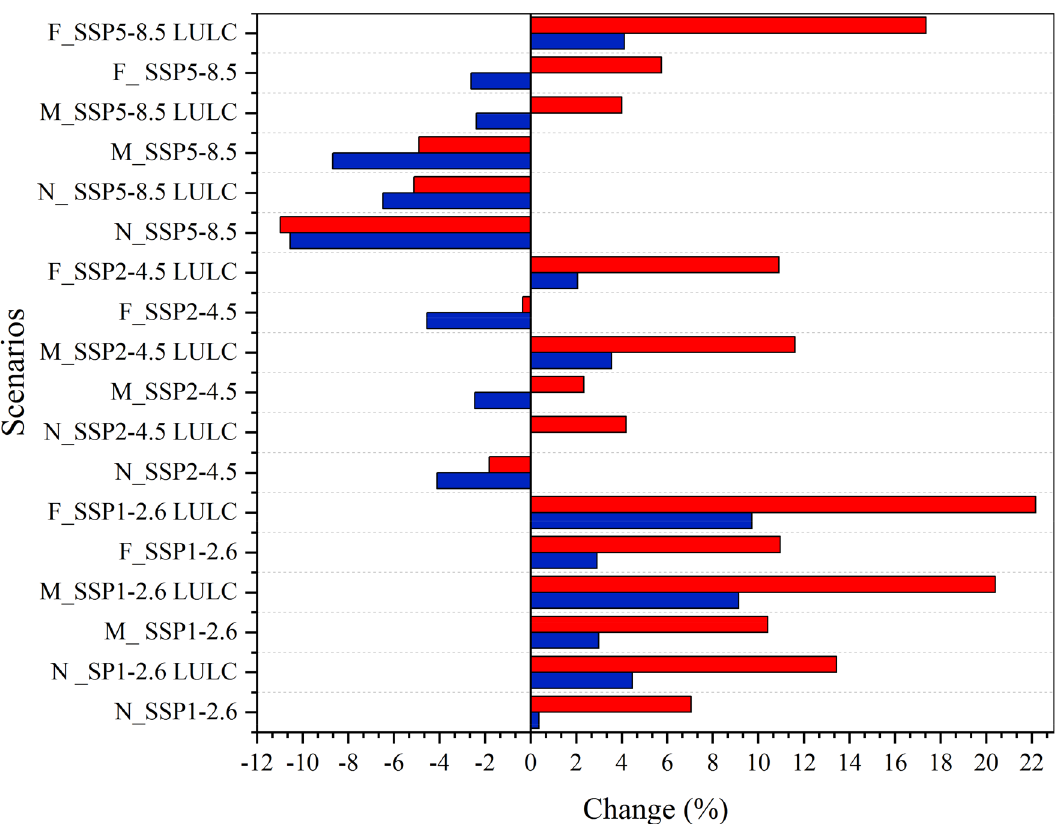
Figure 6. Variation in average streamflow and sediment load under mean multi-GCMs and land use land cover (LULC) changes for different scenarios in different time steps relative to the base period (1989–2020). N: Near future (2021–2050), M: mid future (2051–2080), and F: far future (2081–2100) . Blue bar: streamflow and red bar: sediment load (This figure was created in the Python 3.9 and the Jupyter notebook programming